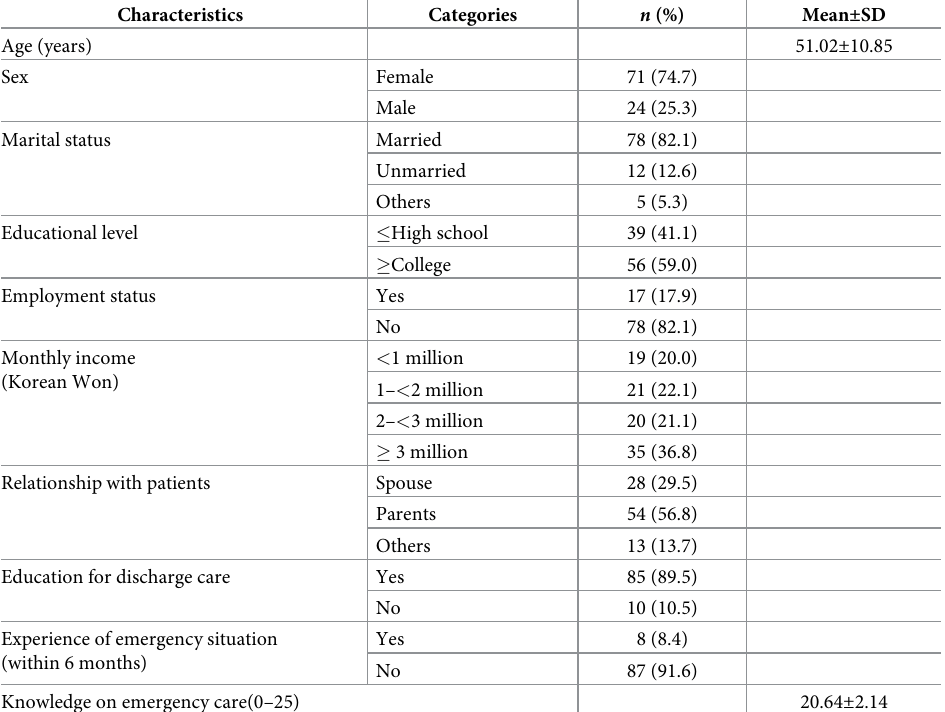
Table 1. General characteristics of family caregivers ( n =